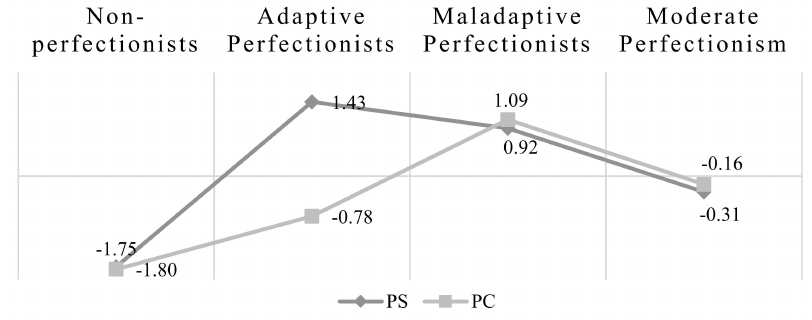
Figure 1. Graphic representation of the standardized average scores for the model of the latent